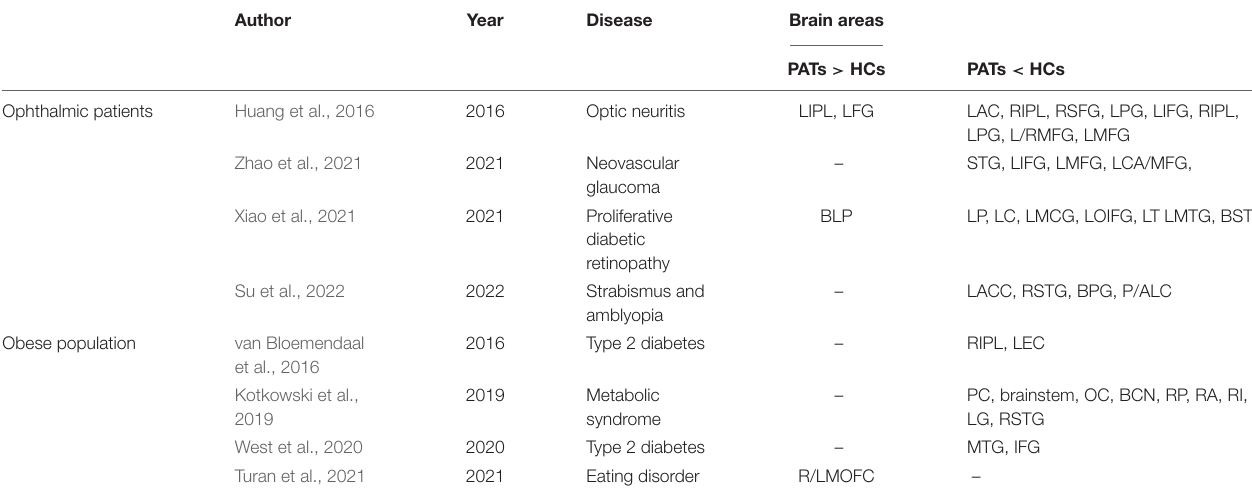
TABLE 3 | VBM method applied in ophthalmic patients and obese